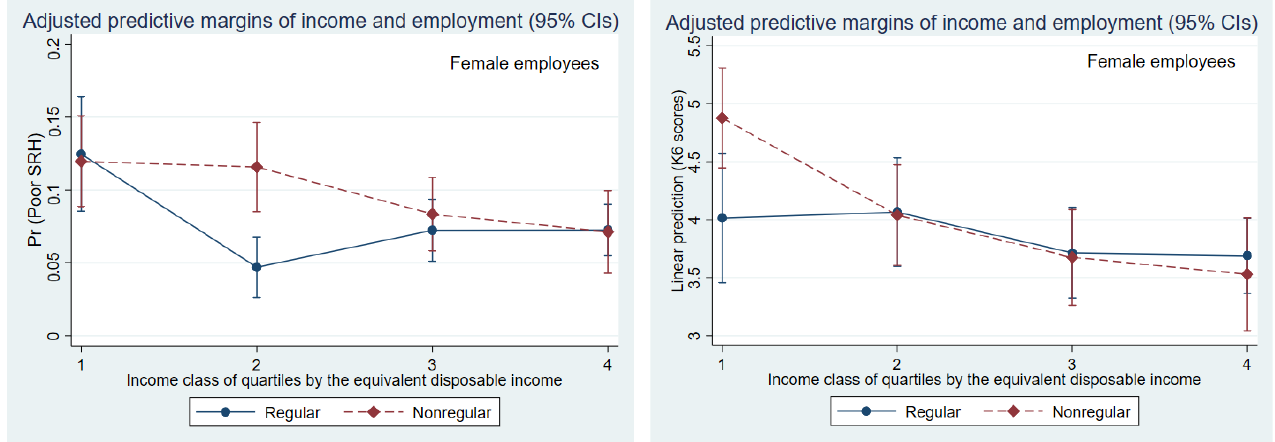
Figure 2. Association between economic status (equivalent disposable income quartile) and poor health (predicted self-rated health and K6 scores) by employment status in female workers.